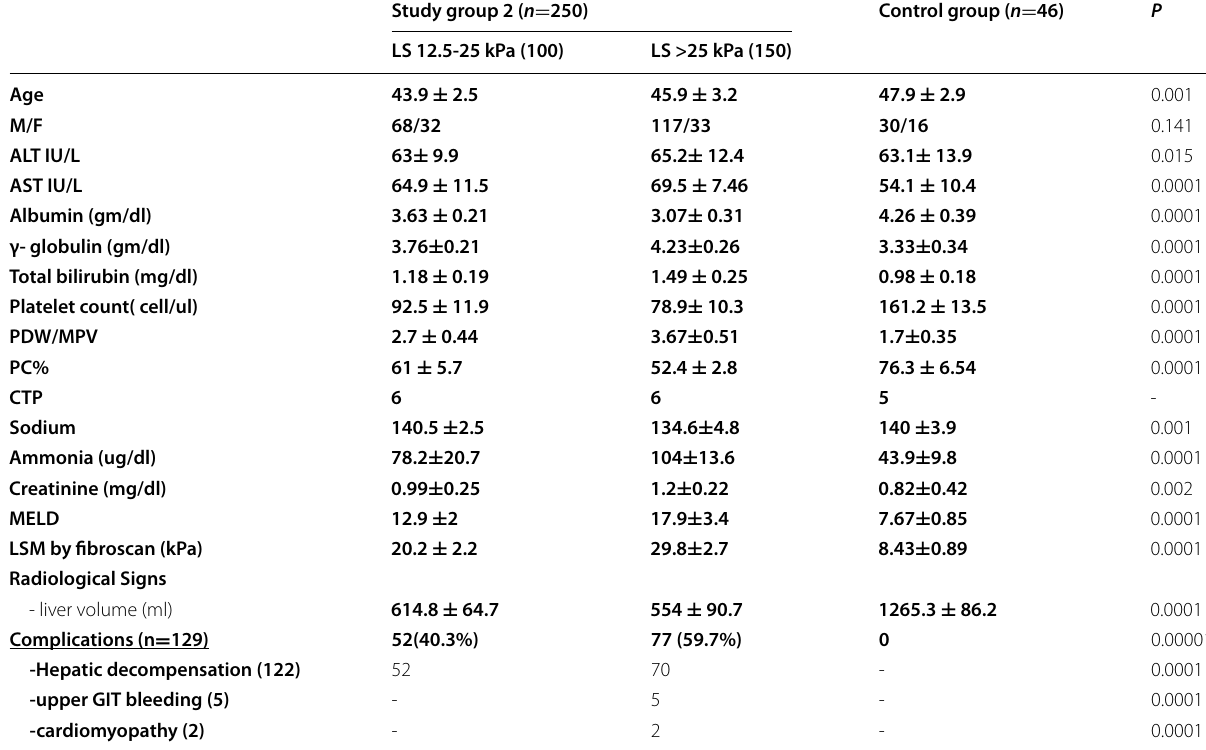
Table 3 Comparison of demographic, laboratory, and radiological characteristics in the group 2 based on liver stiffness, with comparison to the control group treated with sorafenib